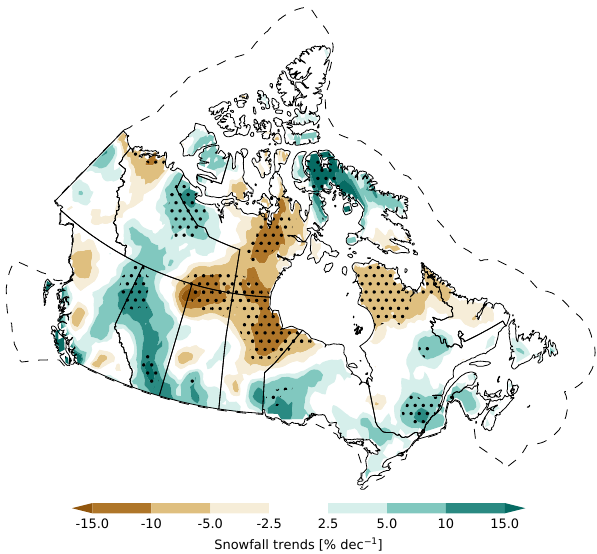
Figure 5. Snowfall trends estimated from CANGRD data. Stippling indicates pointwise significance at the 90th